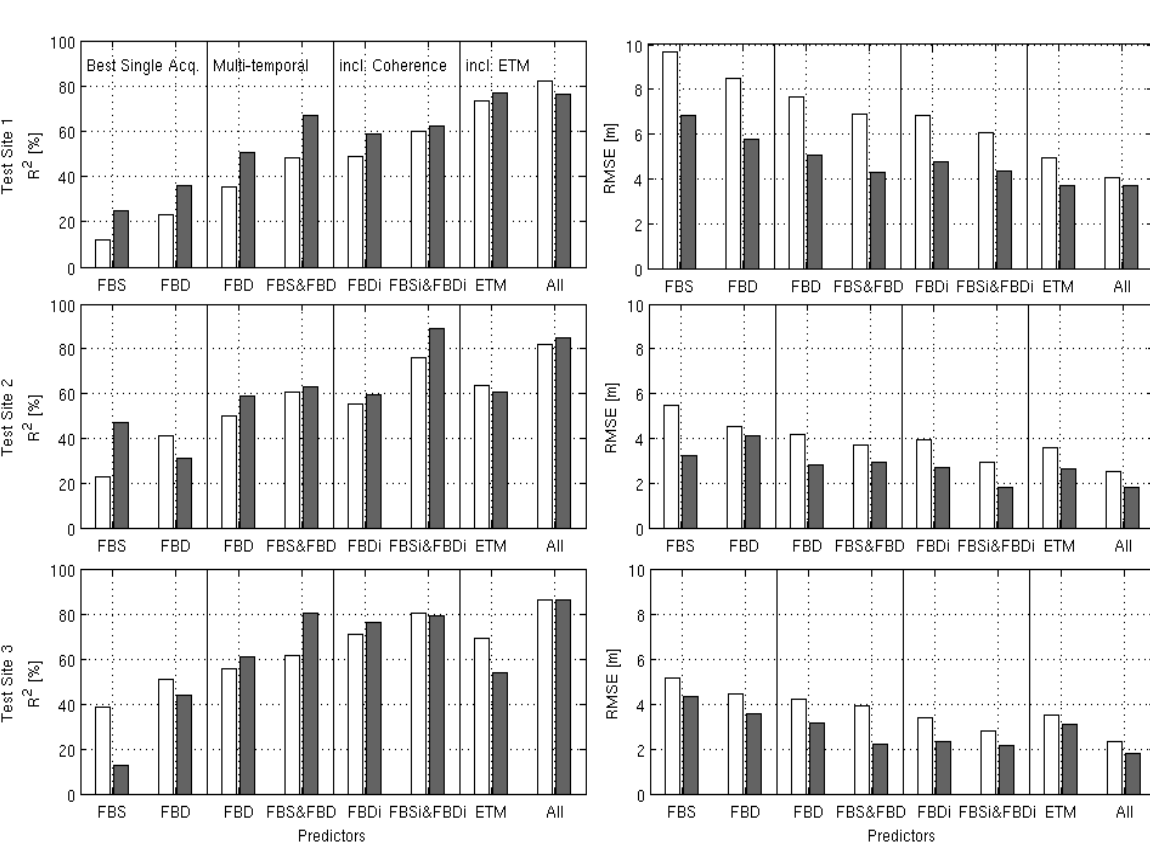
Figure 7. CH retrieval accuracy when using different combinations of the ALOS and Landsat data as predictors in randomForest. FBS, FBD and ETM stand for FBS intensity, FBD intensity and the Landsat data, respectively. FBDi and FBSi/FBDi denote the cases where intensities and coherences were used jointly. The white bars show the retrieval error when comparing the PALSAR/Landsat OOB against the ALS predictions. The grey bars refer to the comparison of the ALOS/Landsat predictions for the inventory polygons and the corresponding in situ